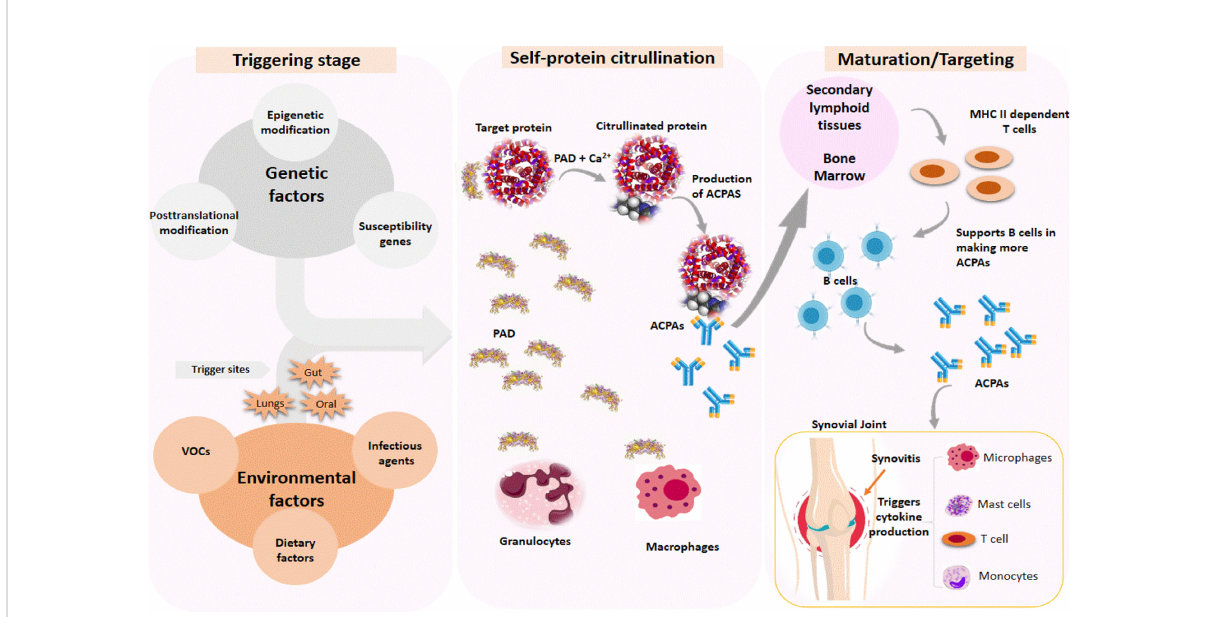
FIGURE 3 Immune response is triggered by genetic and environmental factors in the pathogenesis of rheumatoid arthritis (RA). The triggering process causes citrullination of target proteins found throughout the body, which results in the production of autoantibodies (ACPA) against citrullinated neoantigens. Increased levels of citrullinated neoantigens activate MHC class-II-dependent T cells to support B cells in producing more ACPA, which trigger cytokine production by recruiting other immune cells to the synovial joint, resulting in